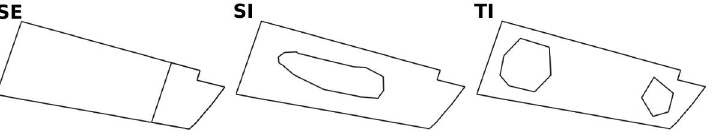
Figure 2. The three theoretical selective harvest scenarios studied in the paper shown for field M8